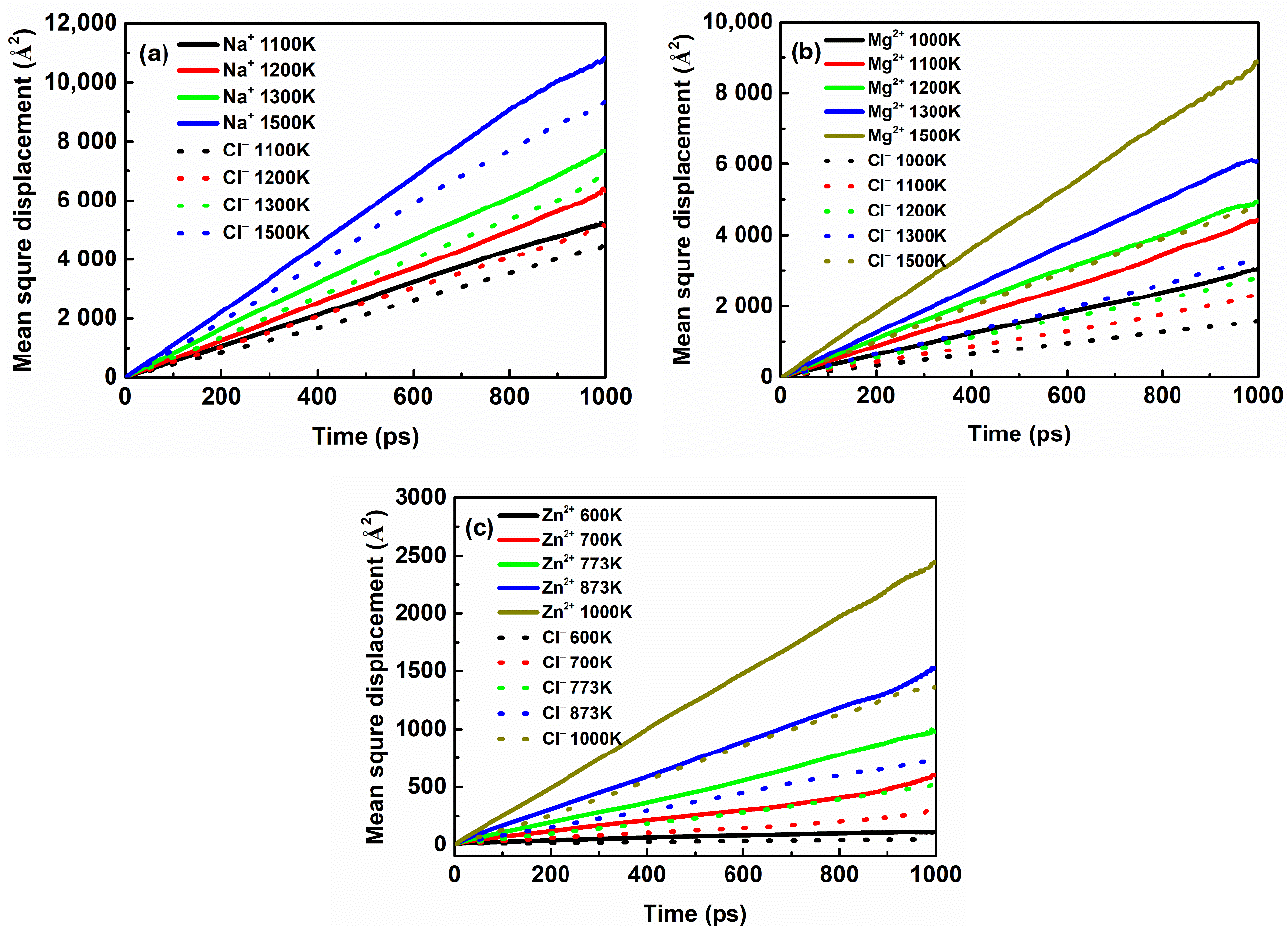
Figure 10. PIM simulated results of MSDs in different temperature: ( a ) Na ion and Cl ion; ( b ) Mg ion and Cl ion; ( c ) Zn ion and Cl ion.